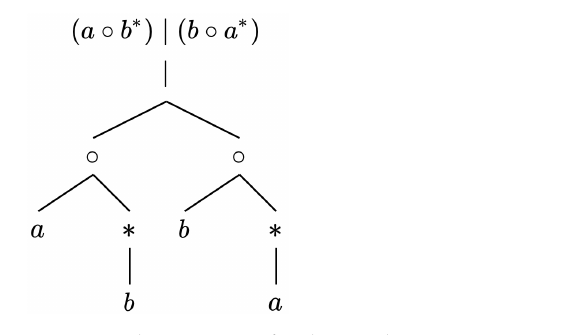
Figure 1. The parse tree for the regular expression p = ( a ◦ b ∗ ) | ( b ◦ a ∗ )